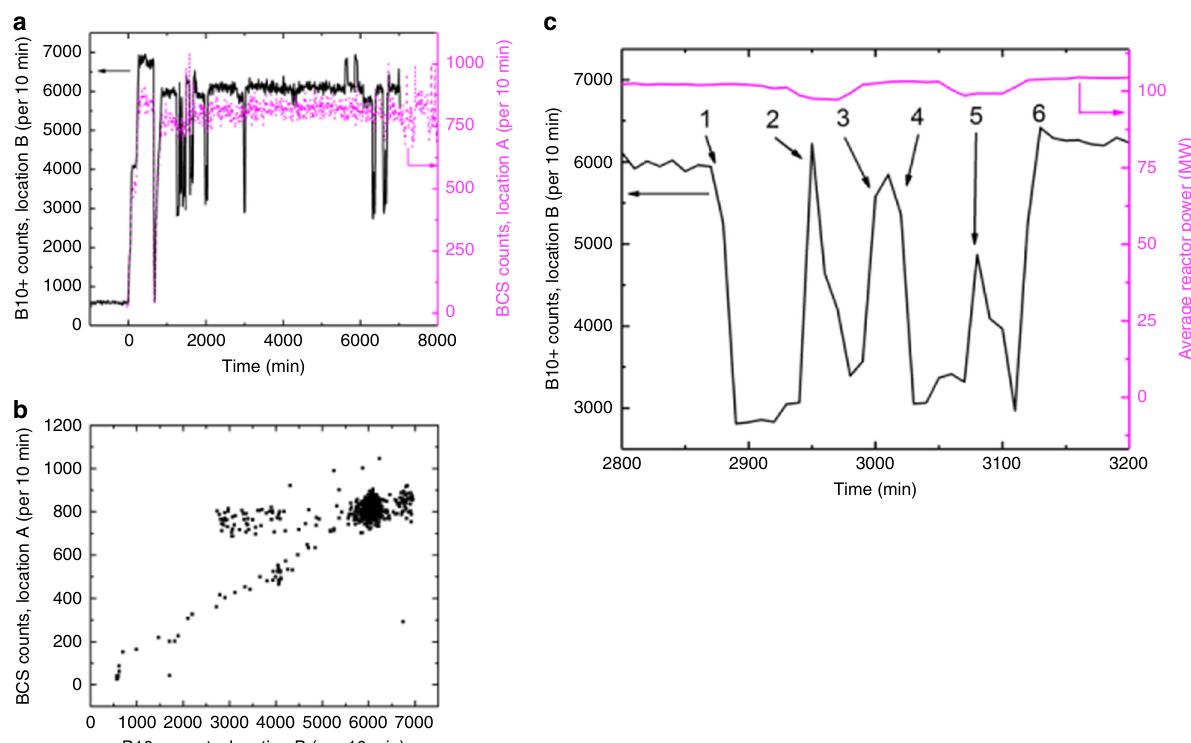
Fig. 4 Detector sensitivity to local environment. a B10 + detector count rate at Location B, and simultaneous BCS detector count rate at Location A, versus time. b The same data from ( a ), demonstrating the correlation between the B10 + and BCS count rates. c An example of how the B10 + detector count rate varied with online refueling activities: (1) fuel rod fl ask parked on top of reactor, (2) fuel rod inserted into reactor core from fl ask at one rod location, followed by removing a fuel rod from reactor core into fl ask at another rod location, (3) fl ask moved away from top of reactor for a break, (4), fl ask moved back onto top of reactor, (5) fuel rod inserted into reactor core from fl ask at one rod location, followed by removing a fuel rod from reactor core into fl ask at another rod location, (6) fl ask moved away from top of